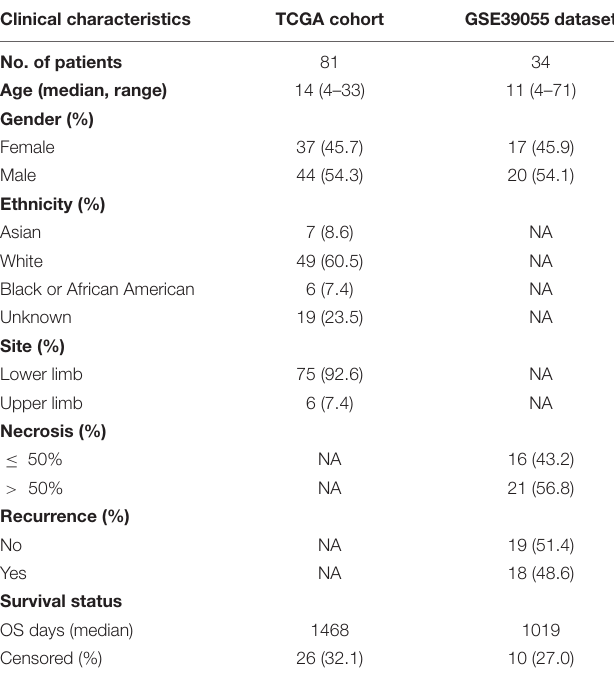
TABLE 1 | Clinicopathological characteristics of osteosarcoma patients used in this